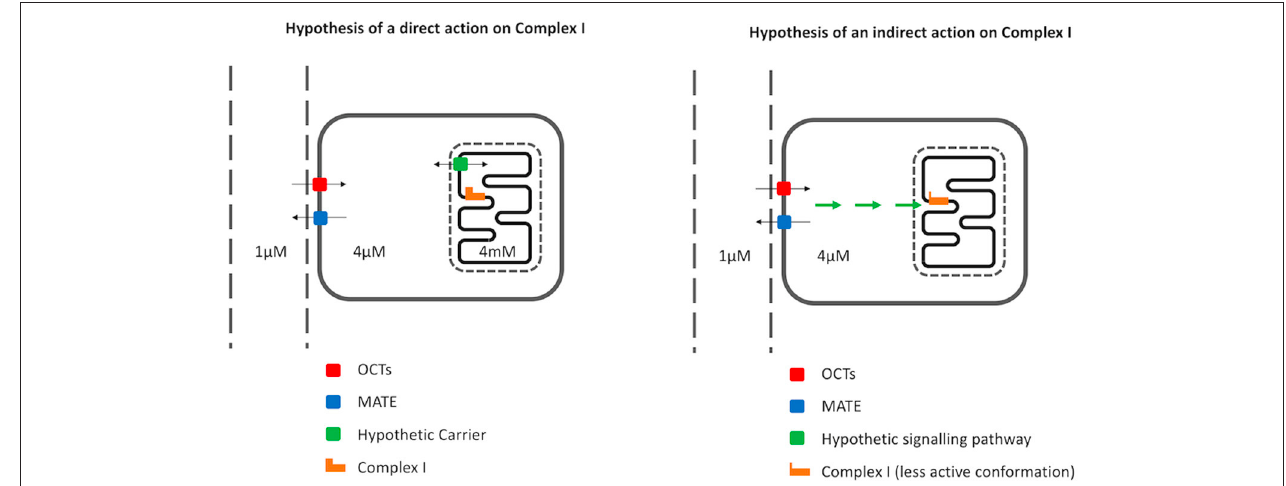
FIGURE 1 | Mechanism of action of metformin on complex I: the direct hypothesis and the indirect hypothesis. Metformin enters cells via Organic Cation Transporters (OCTs) and leaves cells via multidrug and toxin extrusion (MATE) transporters. Assuming a plasma membrane potential of 35mV and a passive mechanism of OCTs and MATE, the cytosolic metformin concentration is expected to be 4 times that of the plasma concentration. In the direct hypothesis (left) , metformin is supposed to enter mitochondria via a hypothetical carrier reaching a matrix concentration 1,000 times that of the cytosol for mitochondrial membrane potential of 180mV. In the indirect hypothesis (right) , metformin does not enter mitochondria but stimulates a hypothetical signaling pathway that eventually modifies Complex I conformation, making it less